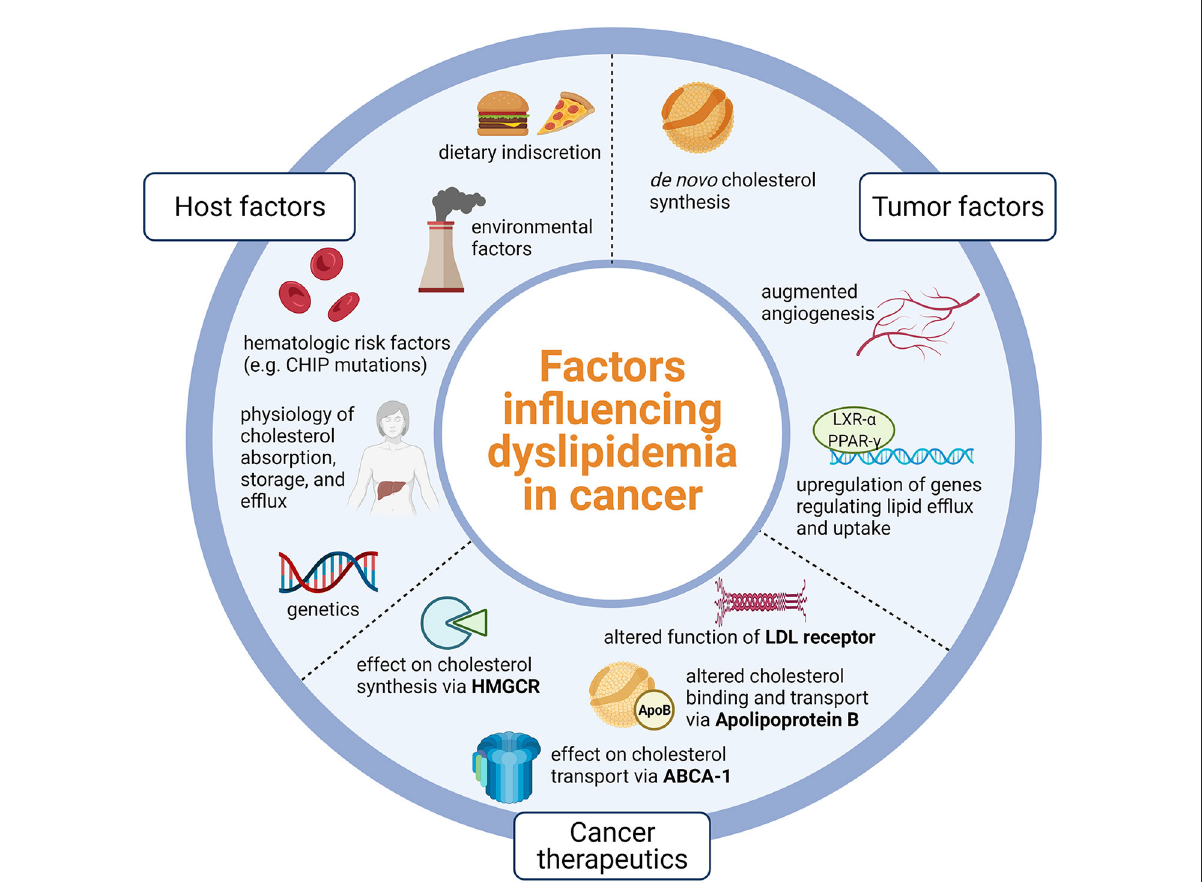
FIGURE1 Host factors such as physiology and lifestyle, tumor factors that promote lipid dysregulation, and nuances of cancer therapeutics likely influence dyslipidemia in cancer. Dyslipidemia in cancer is likely due to host physiology and lifestyle, tumor processes that promote lipid dysregulation, and effects of cancer therapeutics on key points of lipid metabolism. CHIP, Clonal hematopoiesis of indeterminate potential; LXR-alpha, Liver X receptor alpha; PPAR-gamma, Peroxisome-proliferator activated receptor gamma; LDL, Low density lipoprotein; HMGCR, 3-hydroxy-3-methylglutaryl coenzyme A reductase; ABCA-1, Adenosine triphosphate binding cassette subfamily A member 1; Created using